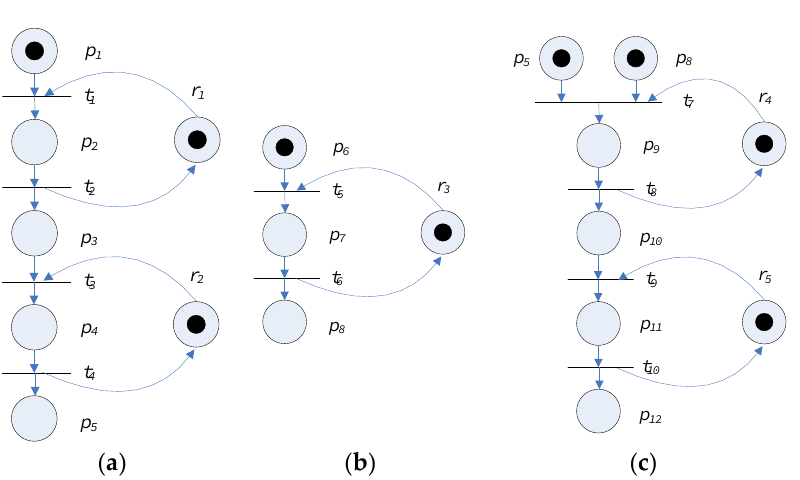
Figure 9. ( a ) A DTPN model Ψ 1 for collaboration of process agent W 1, resource agent R 1 and resource agent R 2; ( b ) A DTPN model Ψ 2 for collaboration of process agent W 2 and resource agent R 3 A DTPN model for resource agent R 2; ( c ) A DTPN model Ψ 3 for collaboration of process agent W 3, resource agent R 4 and resource agent R